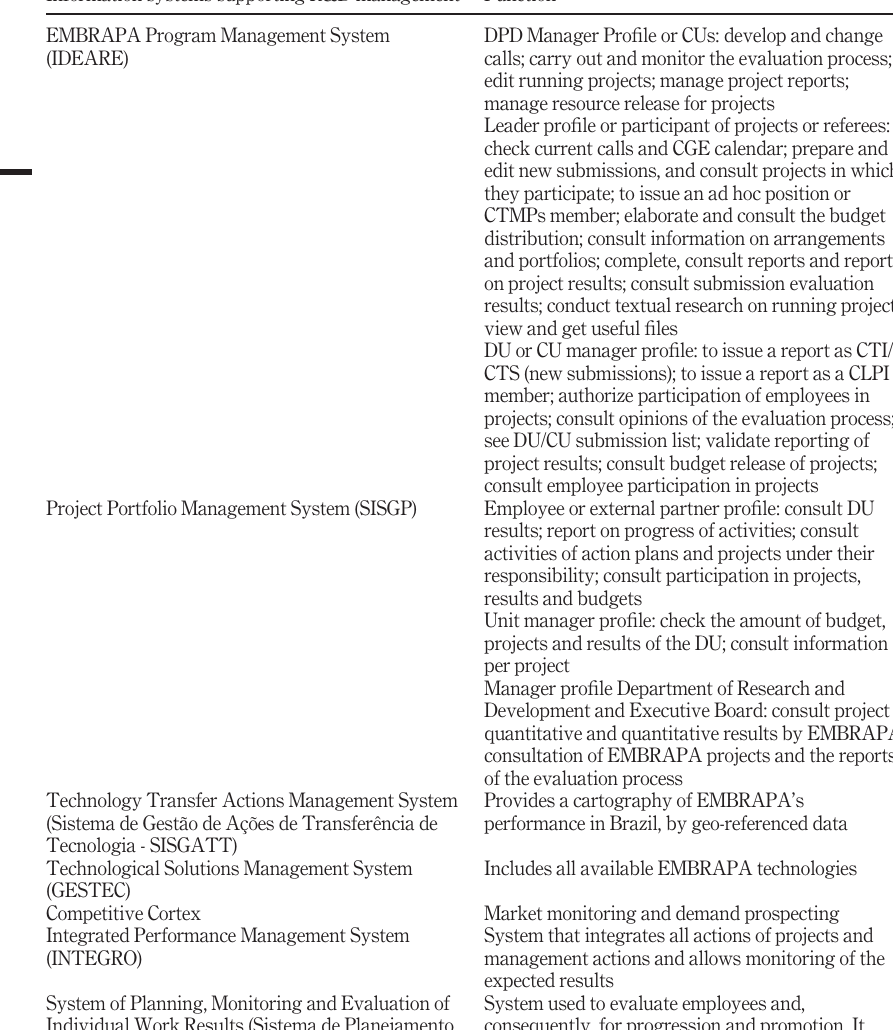
Table V. Main information systems to support R&D management